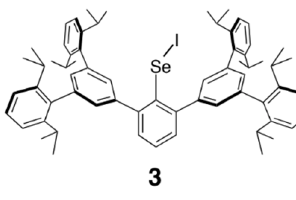
Figure 2. Aryl-substituted selenenyl iodide 3 . Molecules 2015 , 20 , page–page